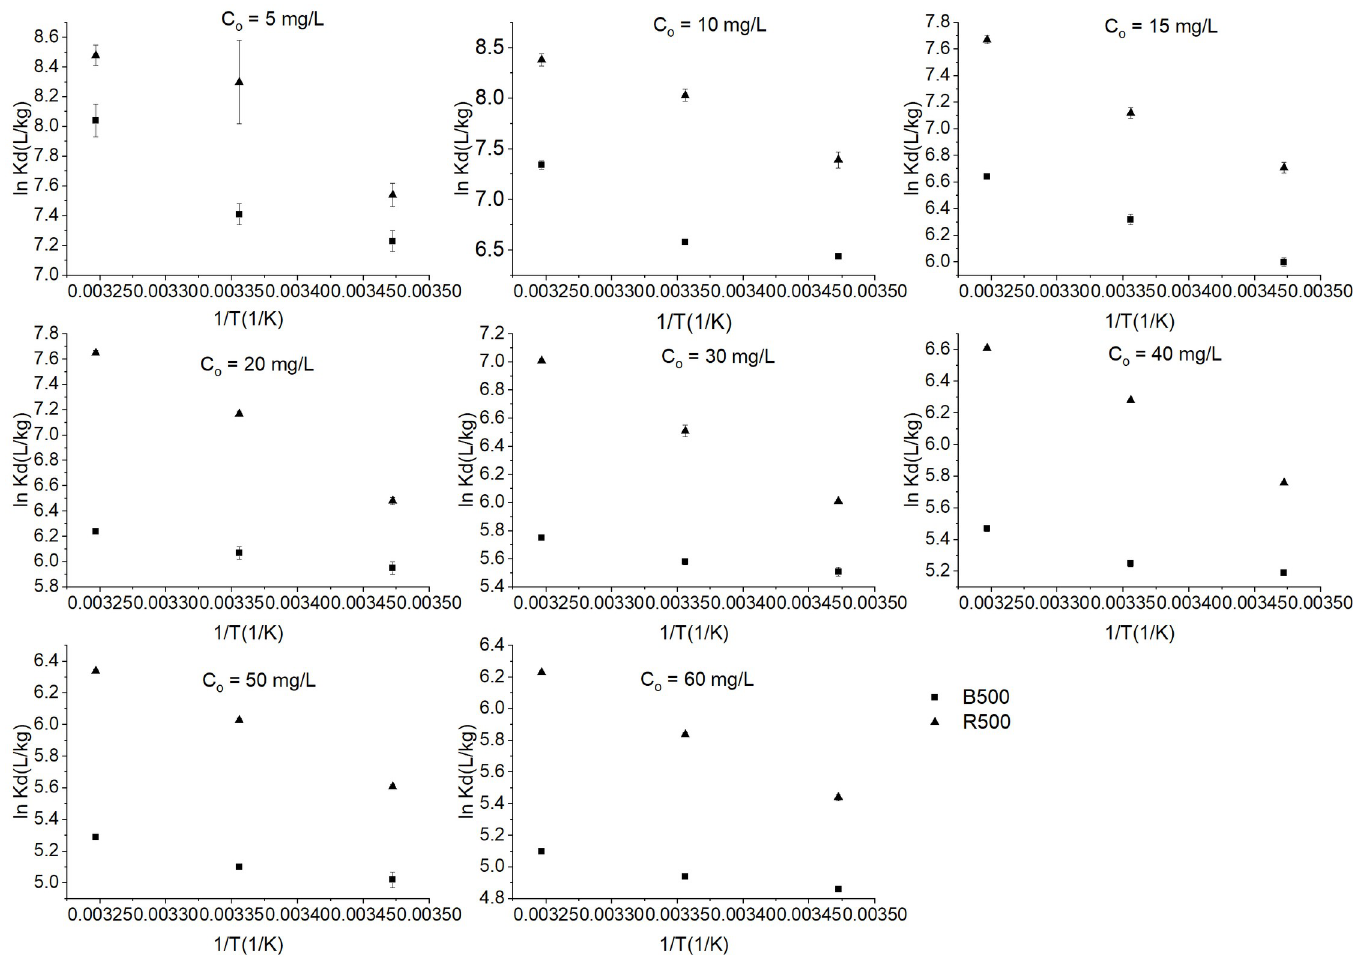
Fig 7. Effect of temperature on sorption coefficient (K d ) for Basic Red 46 on biochars.